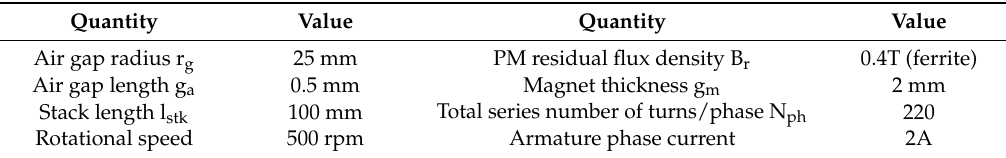
Table 2. Common specifications of the analysis